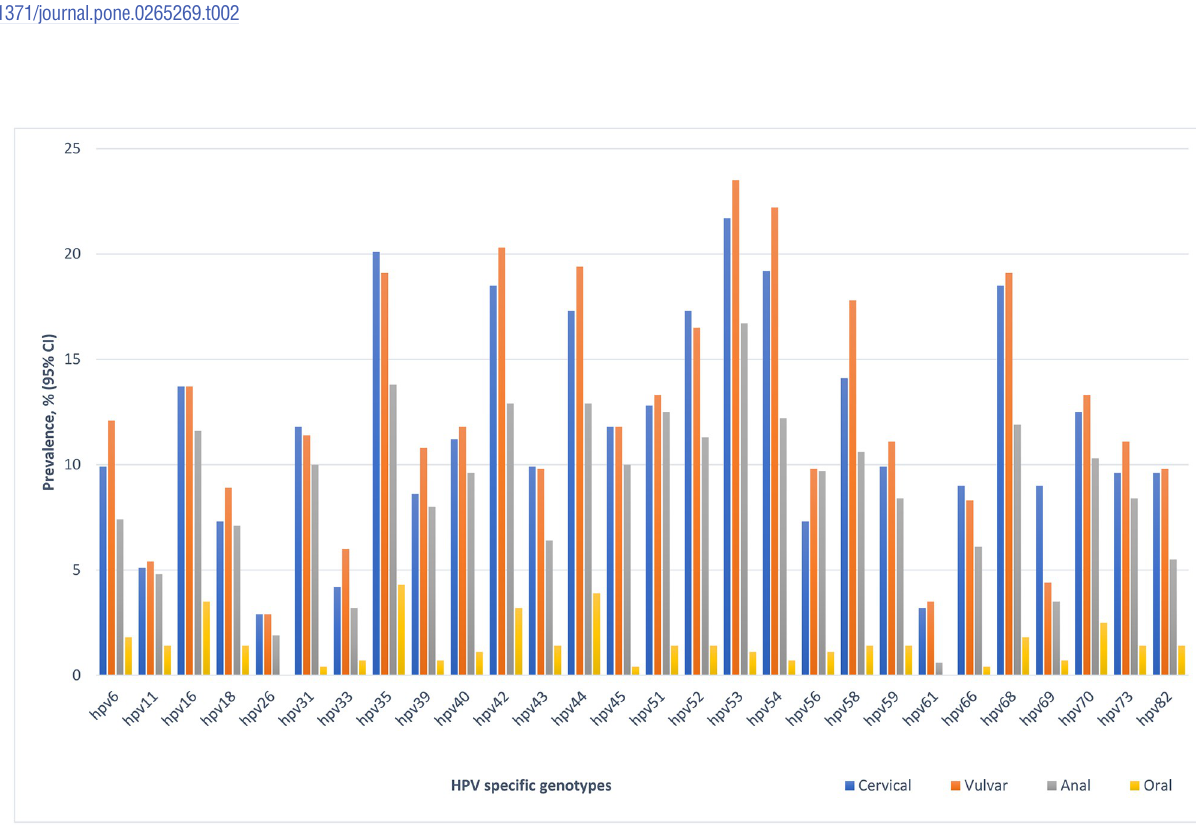
Fig 2. Prevalence of specific HPV genotypes according to the four anatomic sites among brothel based female sex workers in Ibadan